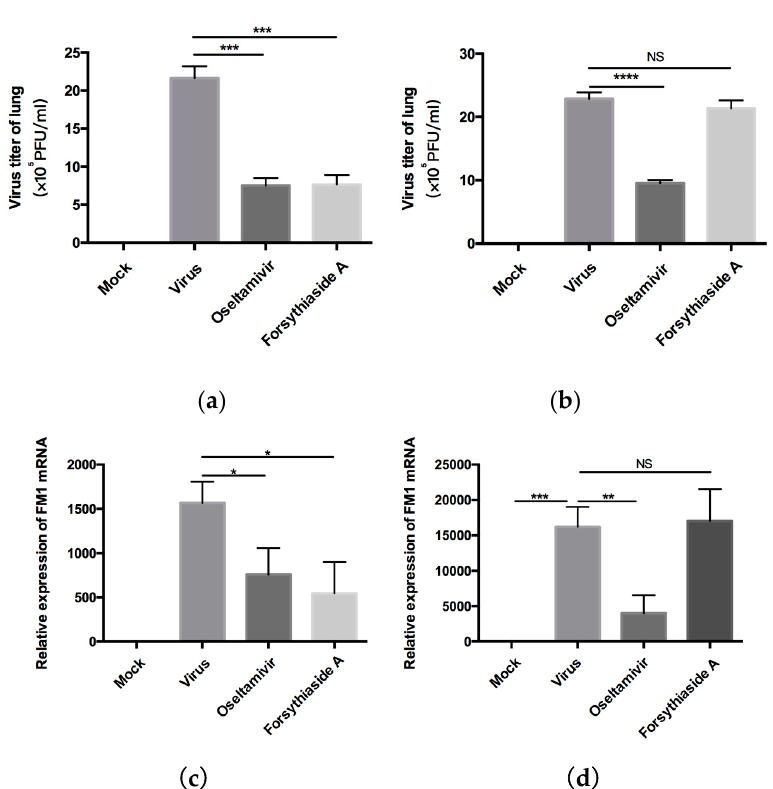
Figure 5. ( a ) and ( b ) indicate the influenza A virus FM1 viral titer in the lung tissues of WT and MAVS − / − mice at day 6 post infection ( n = 6). ( c ) and ( d ) indicate expression of the influenza A virus FM1 mRNA in the lung tissues of WT and MAVS − / − mice at day 6 post infection ( n = 6). * p < 0.05, ** p < 0.01, *** p < 0.001, NS, p >